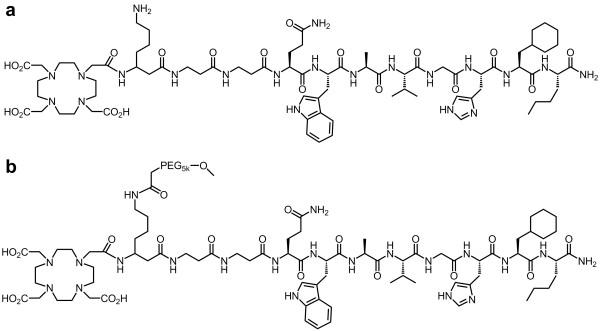
Chemical structures of (a) DOTA-Lys-BN and (b) DOTA-PEG5k-Lys-BN analogues.